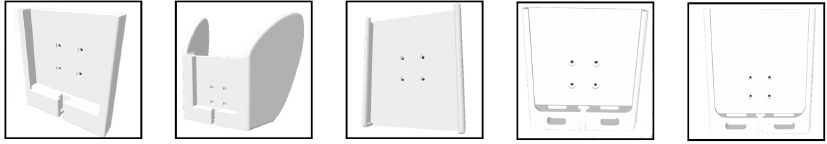
Figure 4. Various 3D drawings for printing robot parts.